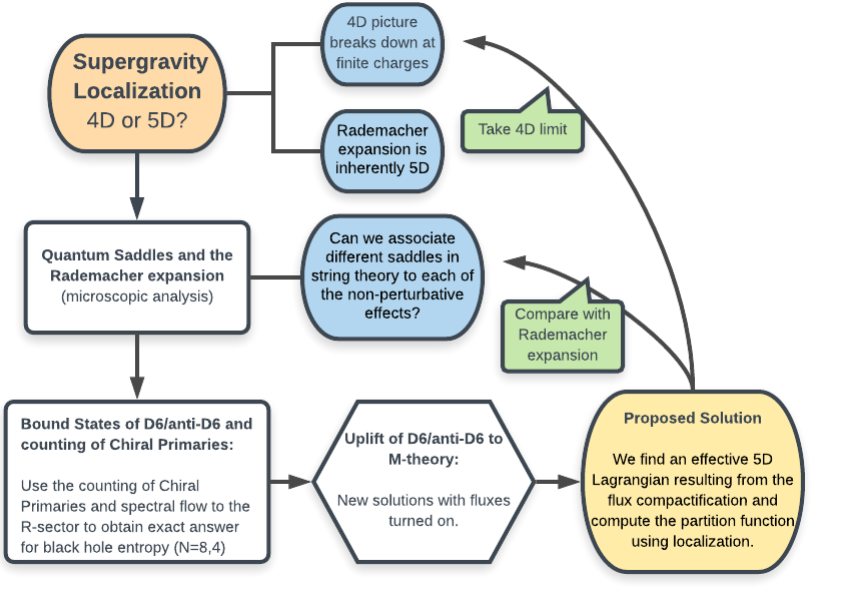
Figure 1 . Work (cid:13)ow of the paper highlighting main questions, steps towards the proposed solution and results. This diagram was built with LucidChart webpage